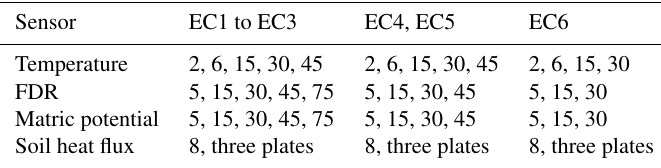
Table 5. Installation depths (in cm) of the soil sensors. During selected periods, additional sensors were installed in greater depths, particu- larly at EC1 to